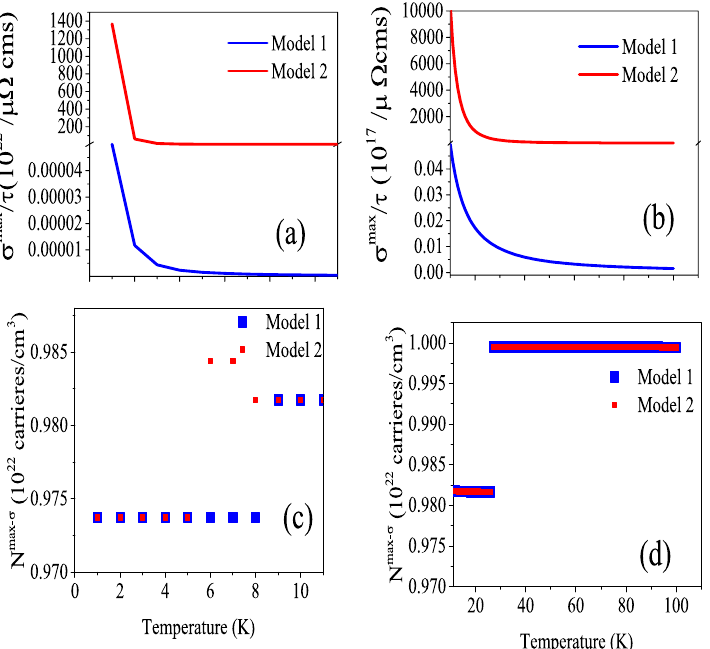
max τ , calculated using